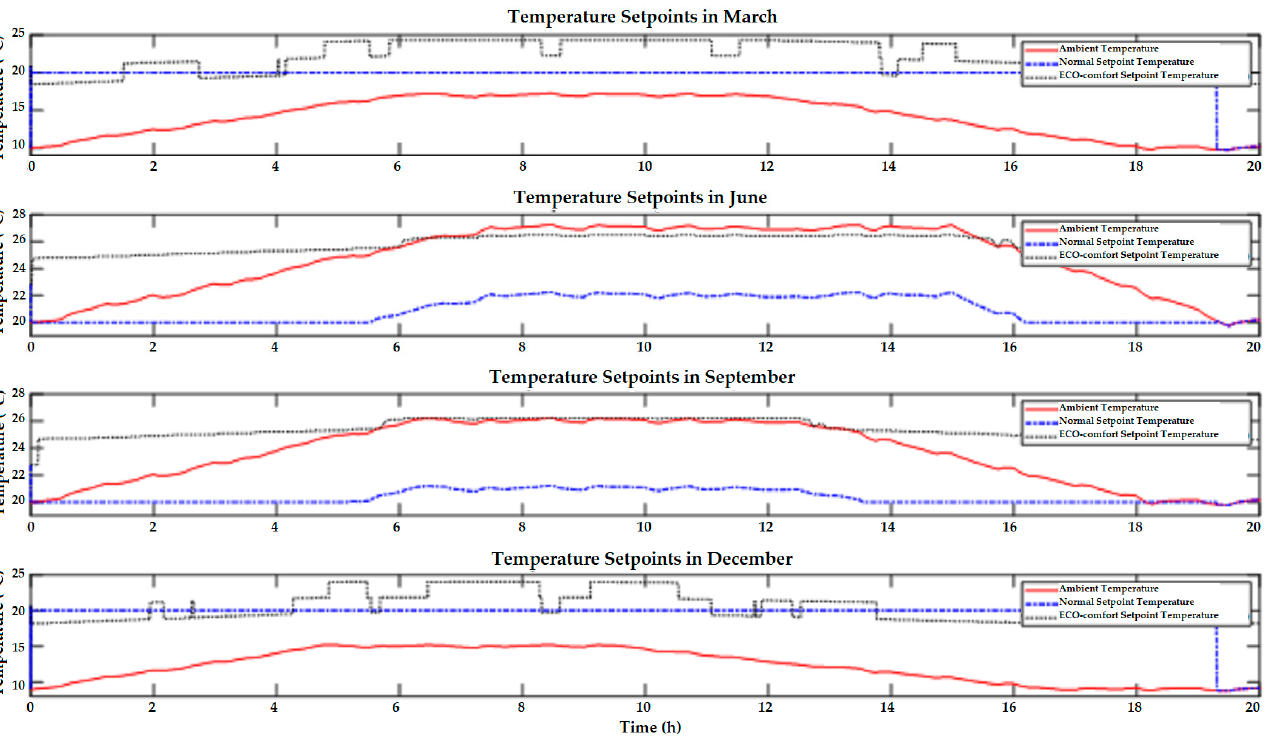
Figure A5. The daily dynamic cabin setpoint temperature for a 12 m bus.